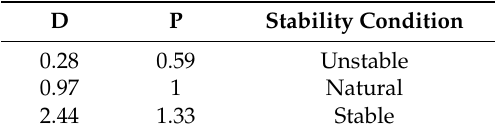
Table 2. Similarity constants (D and P) for di ff erent stability conditions